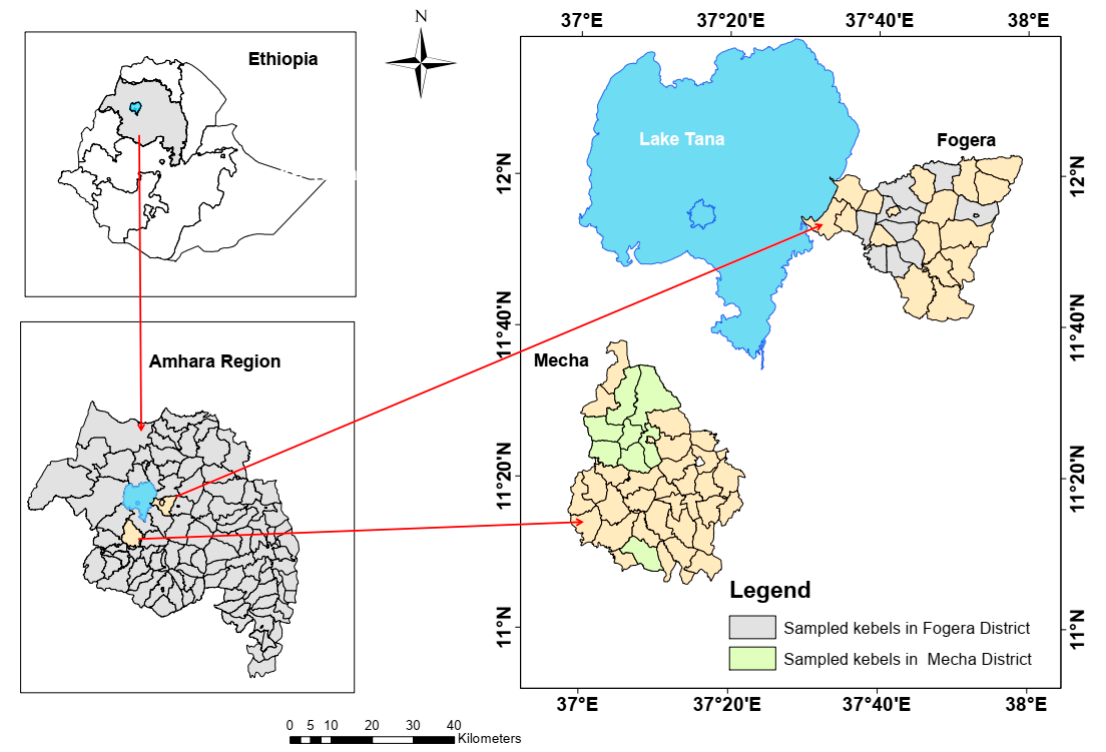
Figure 1. Study area (Source: Authors own elaboration).